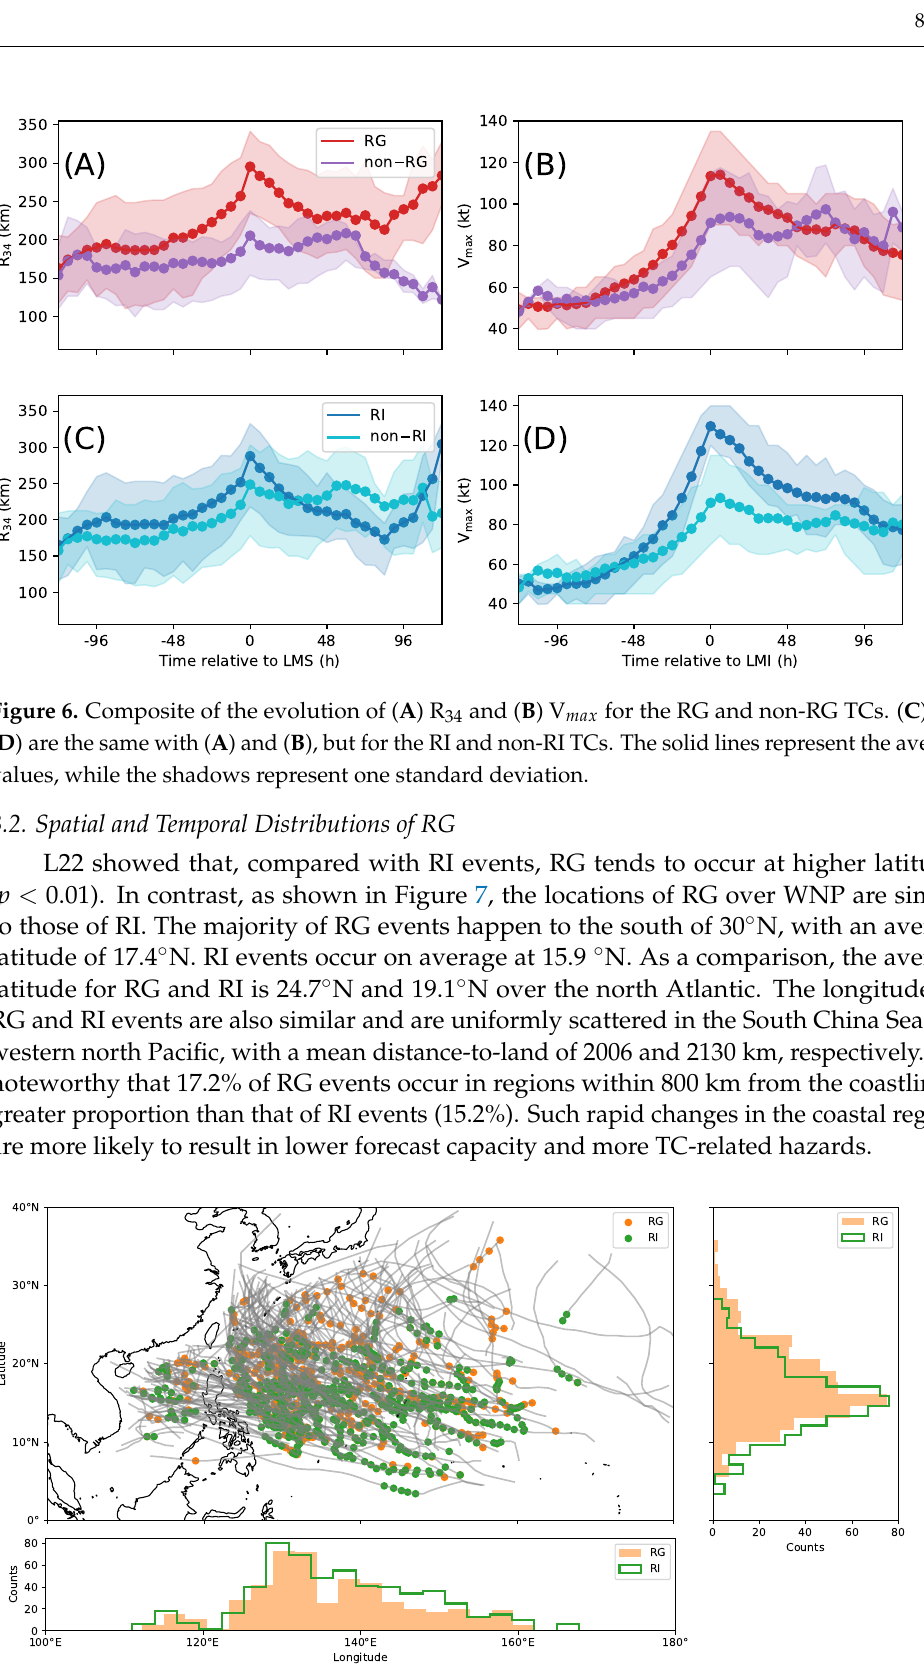
Figure 7. Spatial distribution of rapid growth (orange) and rapid intensification (green)